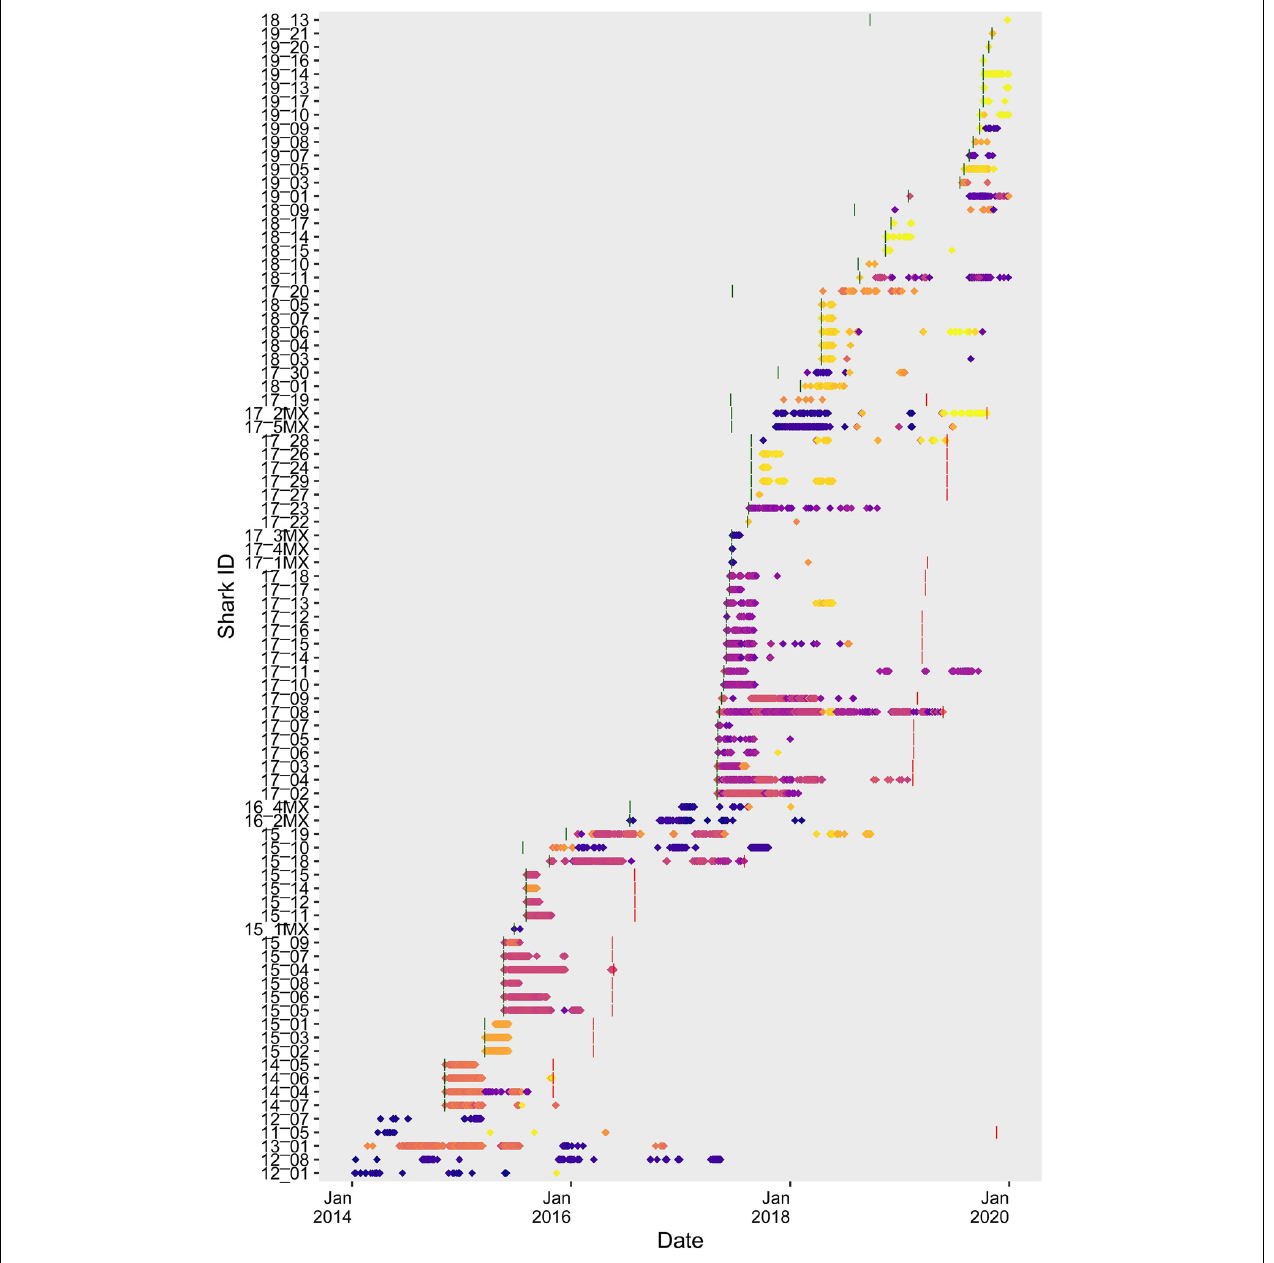
FIGURE 2 | Time series plot showing presence/absence of tagged juvenile white sharks at monitored locations. Points are colored according to individual receiver station latitude demonstrate co-occurrence. Latitudes corresponding to point color are shown in Figure 1 . Green and red vertical lines show tagging date and tag-battery life, respectively. Sharks with bars missing were either tagged prior to 2014, or tag-battery life extends beyond 2019.